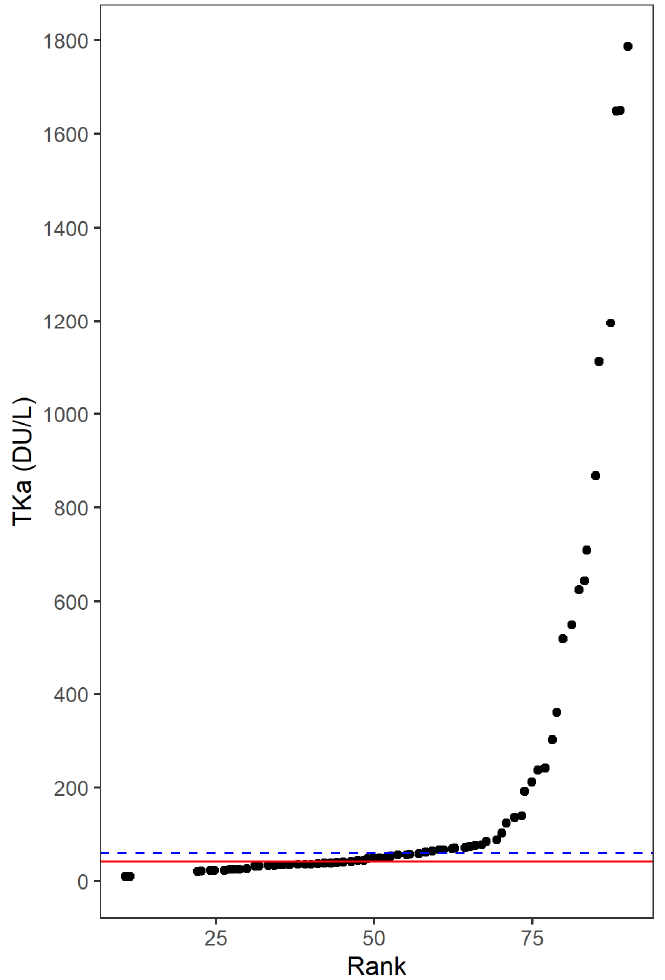
Figure 1. Determining the cut-off for thymidine kinase 1 activity (TKa) in the plasma of metastatic melanoma patients treated with immune checkpoint inhibitors. The figures show the rank (order) of TKa in Divitum ® units per liter (Du/L) on the x -axis and the TK value on the y -axis. When determining the cut-off value for TKa, the most optimal cut-off was considered as the value closest to the median that ensured a differentiation in the TKa value with sufficient numbers of observations in each group. The median TKa at baseline was 42 Du/L. This median (red line) gave a cut-off that divided patients with very similar TKa values into different groups. A cut-off of 60 Du/L (blue line) ensured more differentiation in TKa as well as enough observations in both groups.